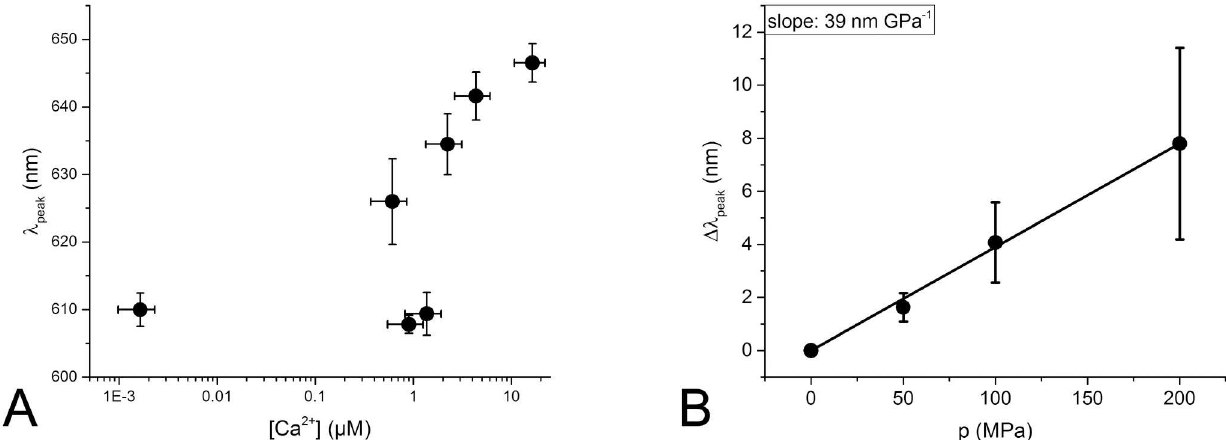
Fig 10. Change in the emission peak wavelength of Fura Red induced by changes in free calcium concentration (A) and pressure (B). A: The wavelength of the emission peak λ peak of all Fura Red measurements taken at all pressures are groupedby the free calcium concentration [Ca 2+ ] of the samples. The emission wavelength does not exhibit a sigmoidal correlationto the free calcium concentration. B: The pressure-induced change in the emissionpeak wavelength Δ λ peak of Fura Red comparedto the emission peak wavelengthat 0.1 MPa of each sample is determined for all samples at all calcium concentrations and plotted over the hydrostatic pressure. The averagechange in wavelength is with 0.04 nm/MPa negligible within the observed pressure range.